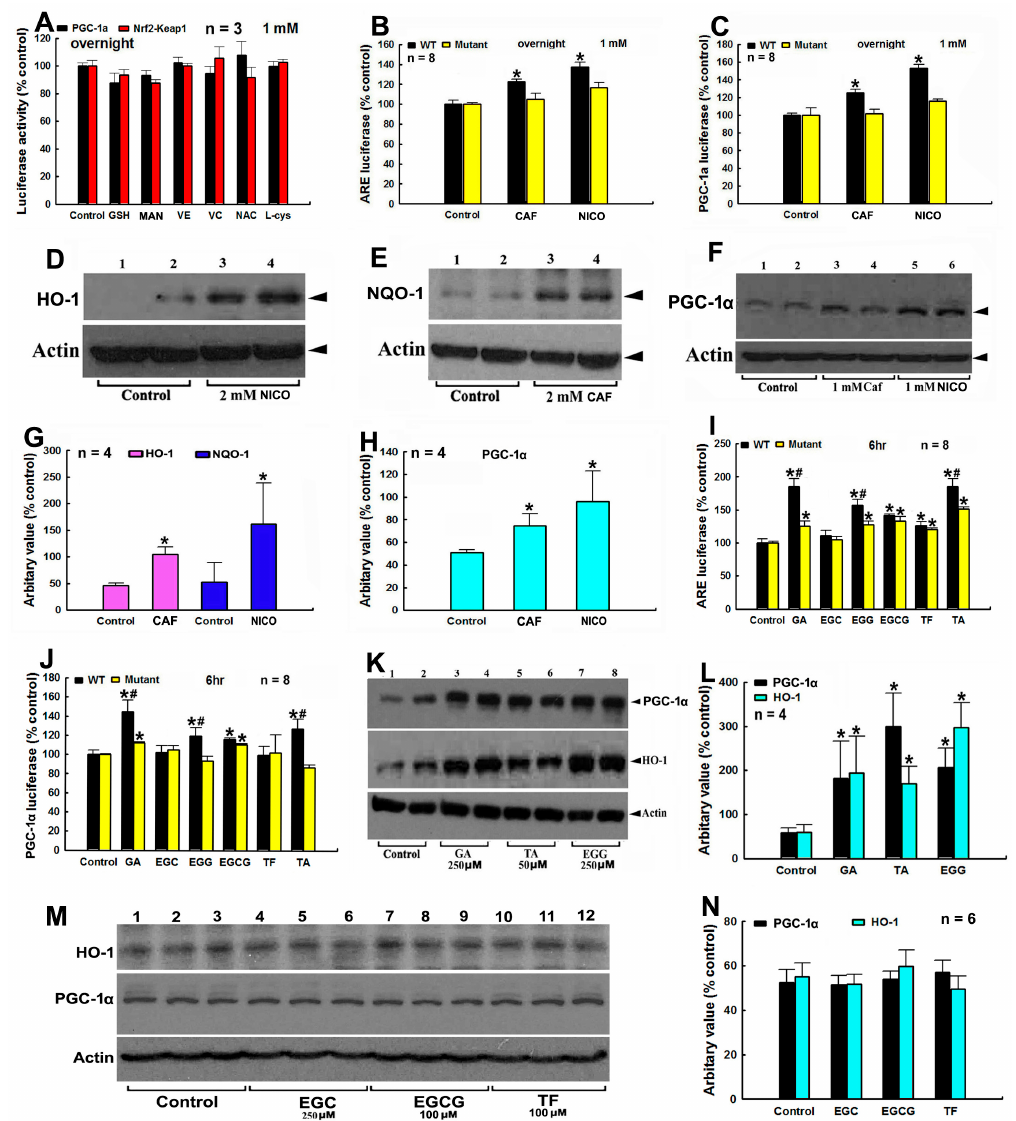
Figure 4. Modulations of Nrf2-Keap1 and PGC-1 α signaling pathways by tea polyphenols and